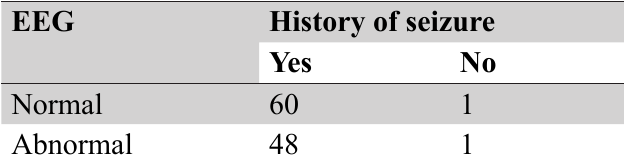
Table 3. EEG findings and history of